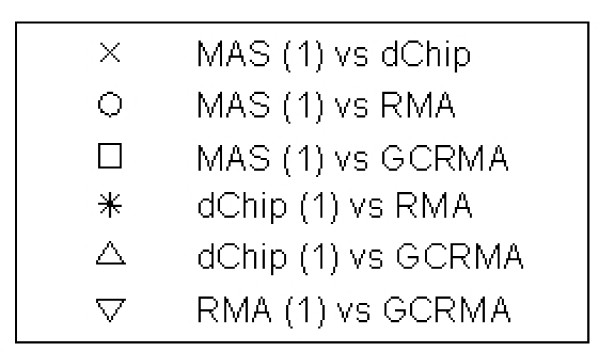
D: Legend to markers in Figures 3B-C.